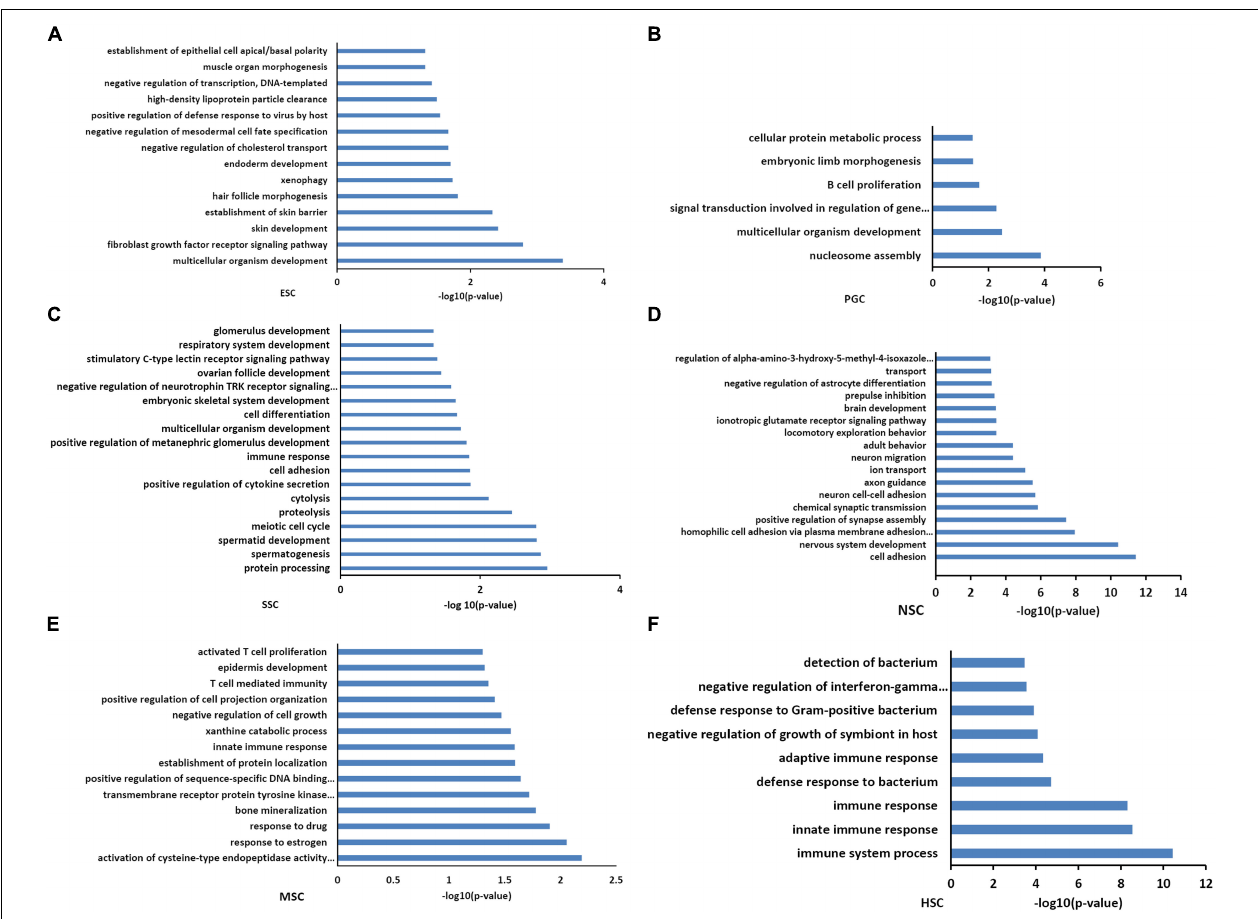
FIGURE 3 | Functional annotation of the six stem cell types correlated modules. GO analysis of genes in six stem cell types correlated modules were annotated by DAVID 7.8. ESC enriched GO terms included multicellular organism development, endoderm development, and the establishment of various organs and cells (A) . GO analysis of PGCs correlated modules genes were involved in multicellular organism development and embryonic limb morphogenesis (B) . SSC correlated module genes were involved in cell differentiation, spermatogenesis-related processes, and multicellular organism development (C) . NSC correlated module genes were involved in neural system development (D) . MSC correlated module genes were involved in T cell development, T cell mediated immunity, immune responses, and bone mineralization (E) . HSC correlated module genes were involved in the immune response (F)